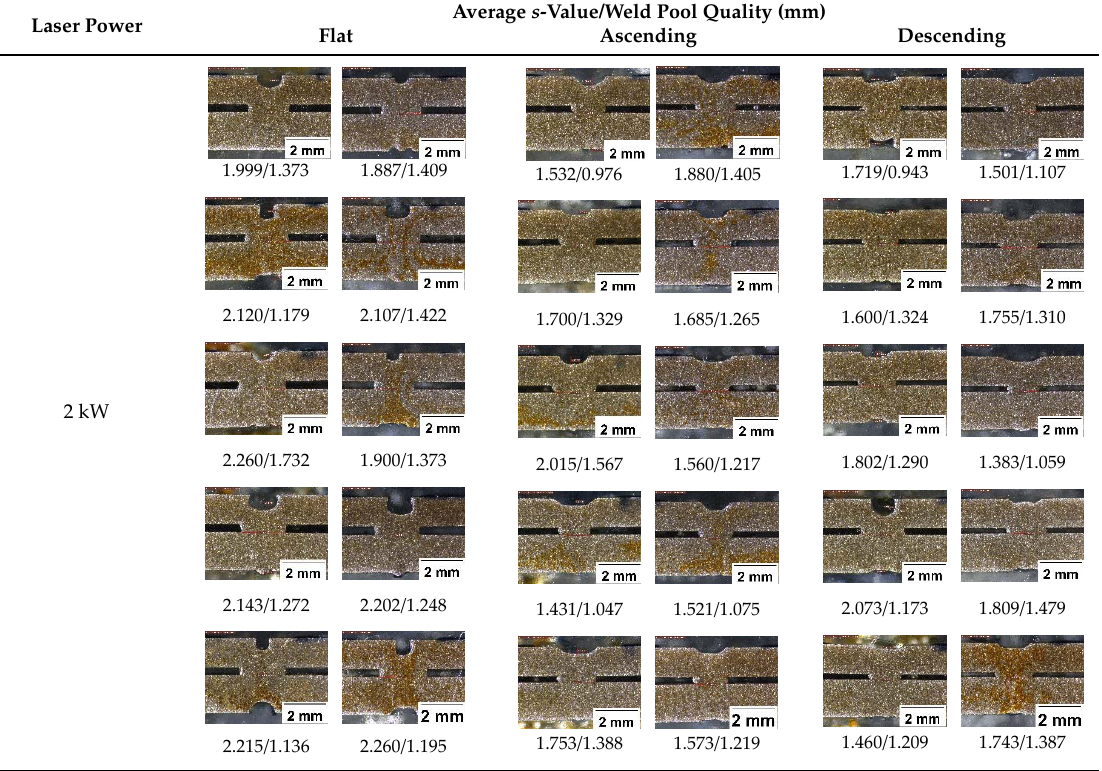
Table 11. The laser welding experimental data of experiment #2 ‐ 2.